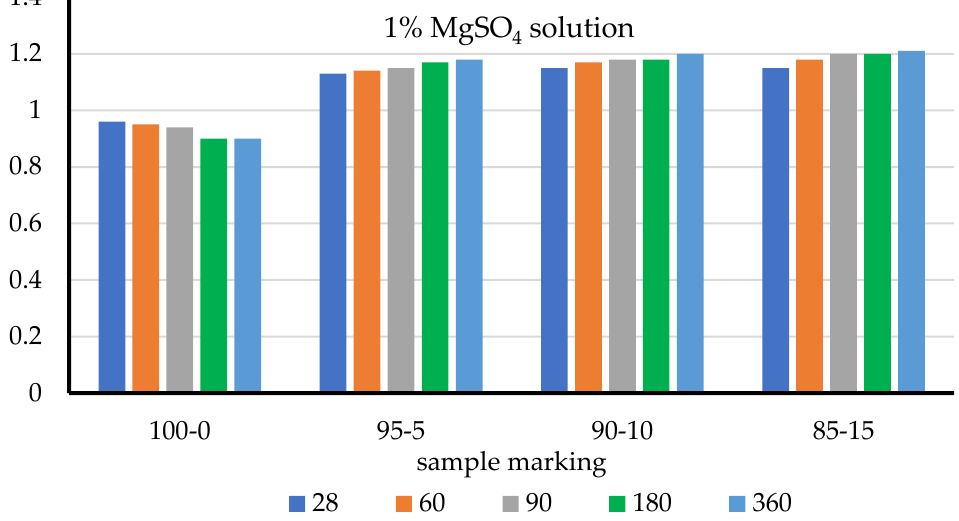
Figure 11. The coefficients of corrosion resistance of the mixed cement samples during different periods (days) of hardening in 1% MgSO 4 solution.